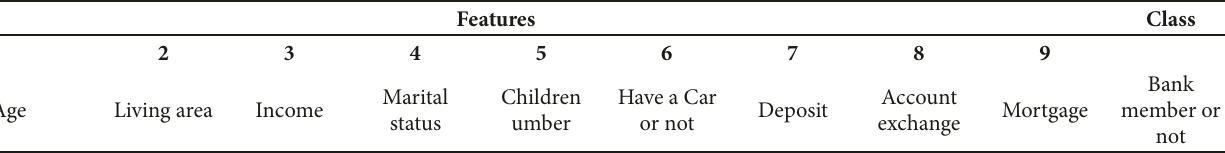
Table 5: The 9 features and classes of dataset “Bank”.